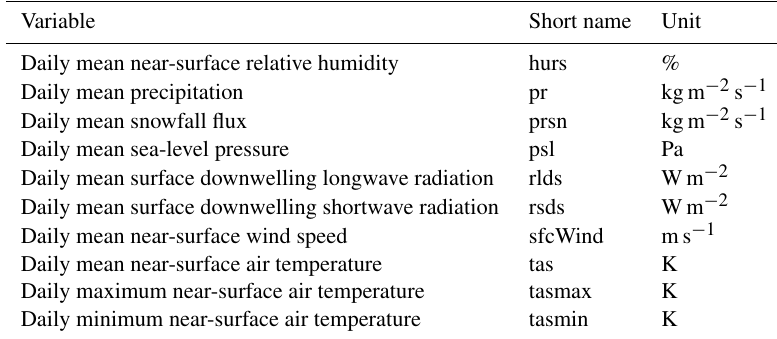
Table 1. Climate variables considered in this study. Variable Short name Daily mean near-surface relative